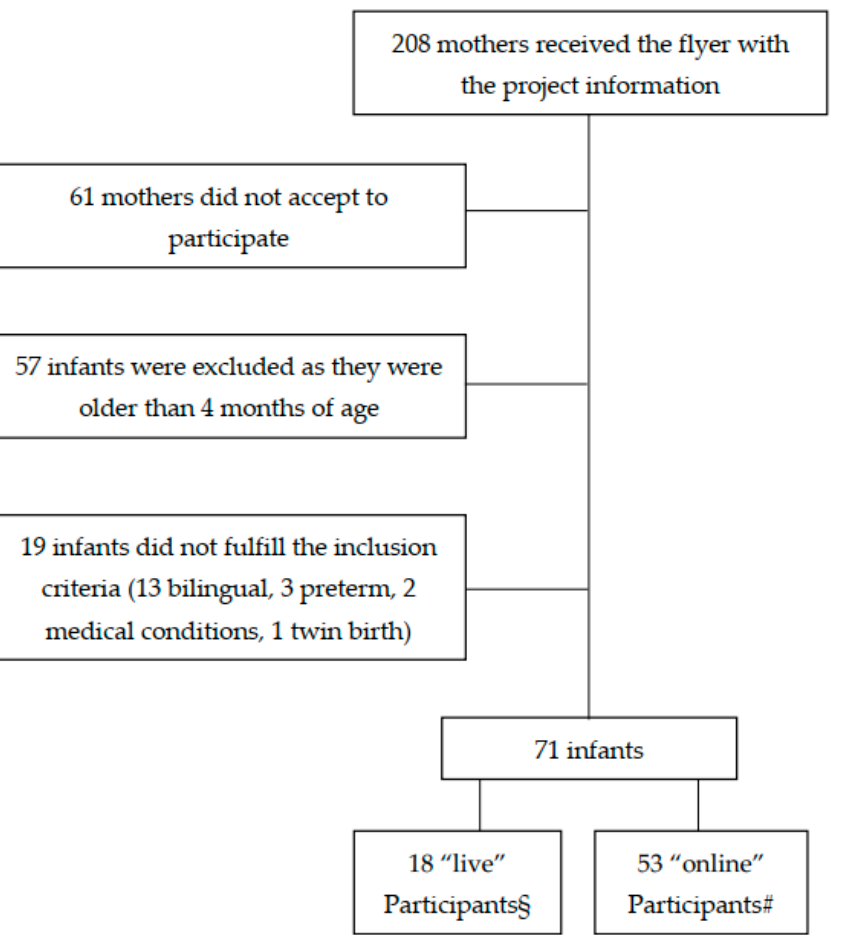
Figure 1. Flow chart of infant recruitment. § These participants were tested before COVID-19 restrictions were applied in Italy. # These participants were tested after the applications of COVID-19-related restrictions.